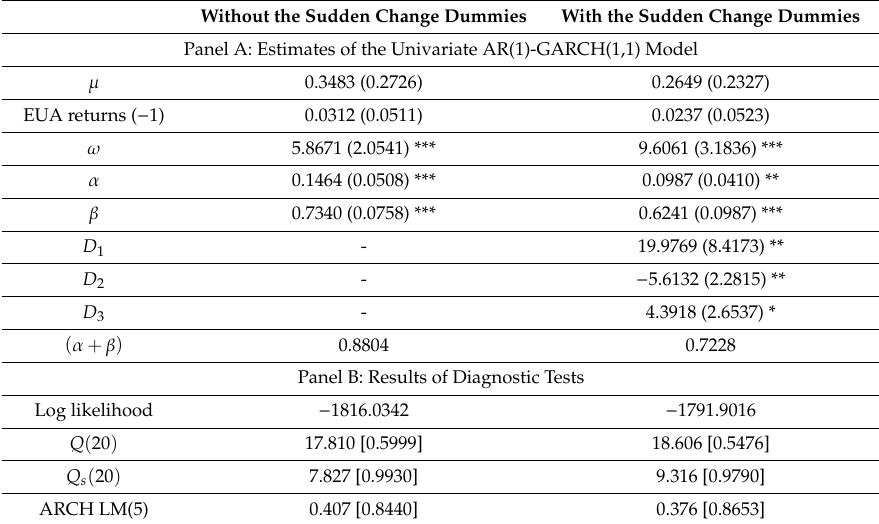
Table 3. Estimation results of AR(1)-GARCH(1,1) model for the EUA